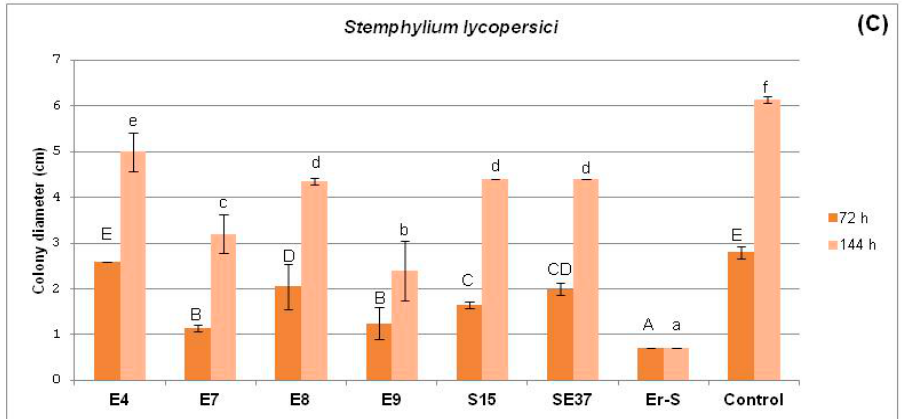
Figure 6. Antifungal activities of volatiles from endophytic bacteria (E4, E7, E8, E9, S15, SE37 and Er-S as control) against fungal pathogens: ( A ) A. alternata , ( B ) C. cassiicola and ( C ) S. lycopersici. Values are means of three independent biological replicates and error bars represent the standard deviation, letters in common on the bars are not significantly different according to the Tukey test at p ≤ 0.05.